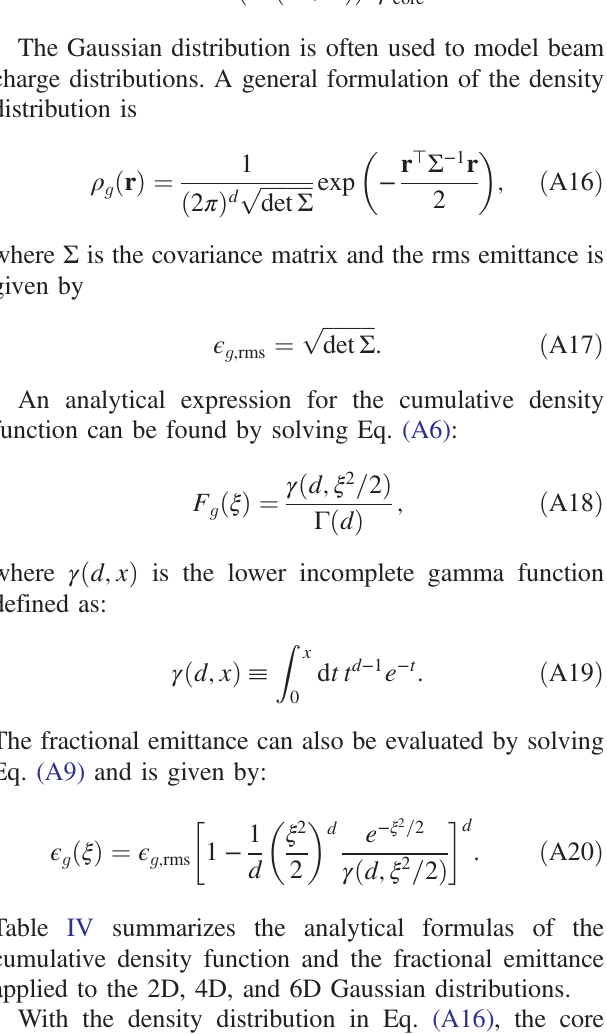
ξ Þ , and fractional emittance, ϵ ξ Þ , of a g ð g ð . The ratio between the core and rms g; rms